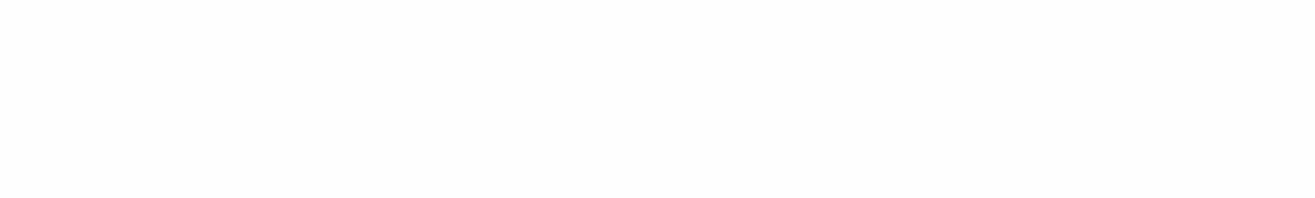
FIGURE 18 Bifurcation diagram of Y with noise (cr =0.08). FIGURE 20 Trajectory of Y with noise when c=2.5